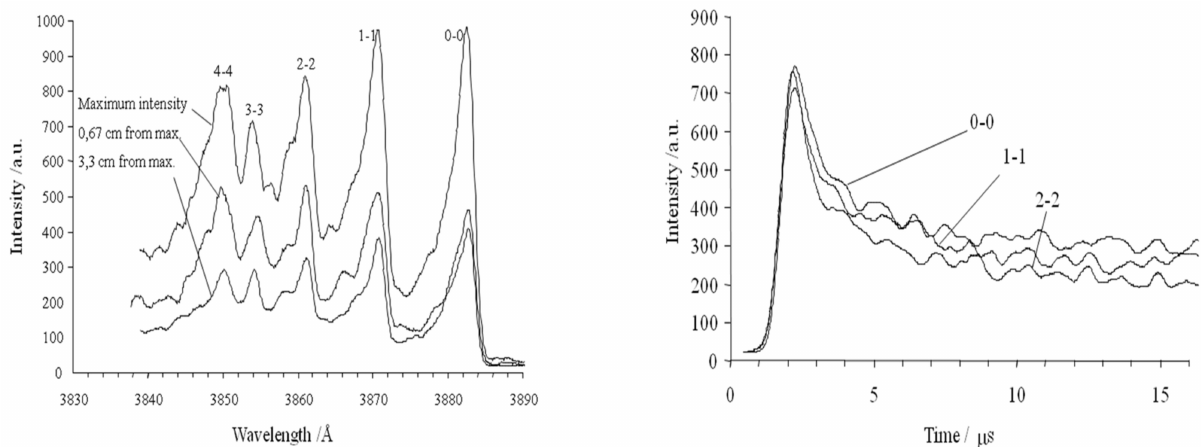
Figure 52. Left: Spectrum of CN violet ∆ v = 0. Right: Time profile of CN violet ∆ v = 0 for the Case 1of Table 5 (from [54]).